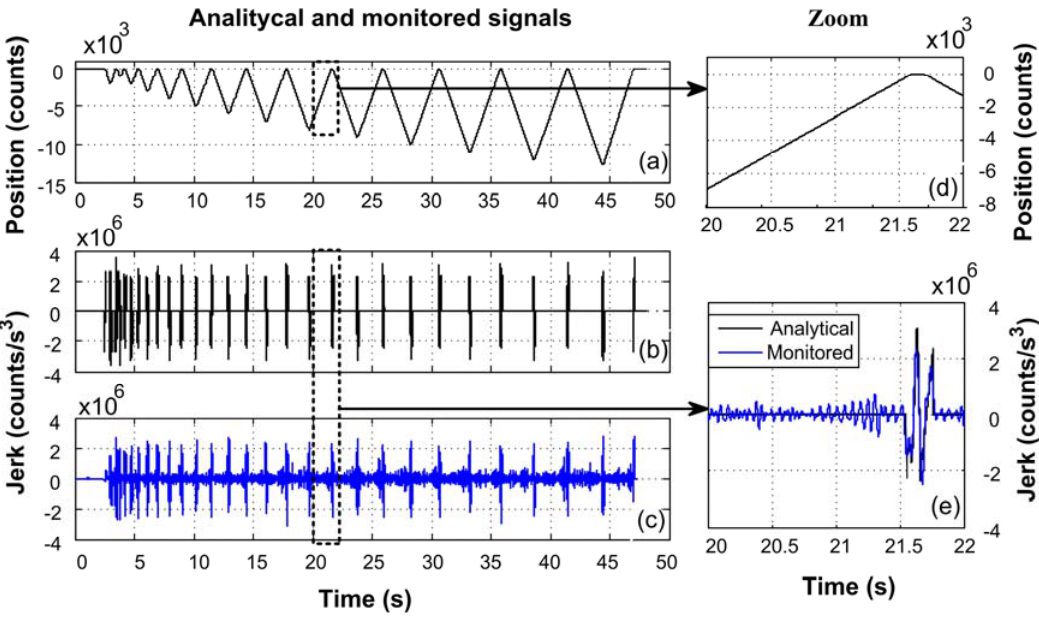
Figure 16. (a) Position, (b) analytical jerk, (c) monitored jerk, (d) zoom of position, (e) jerk analytical and